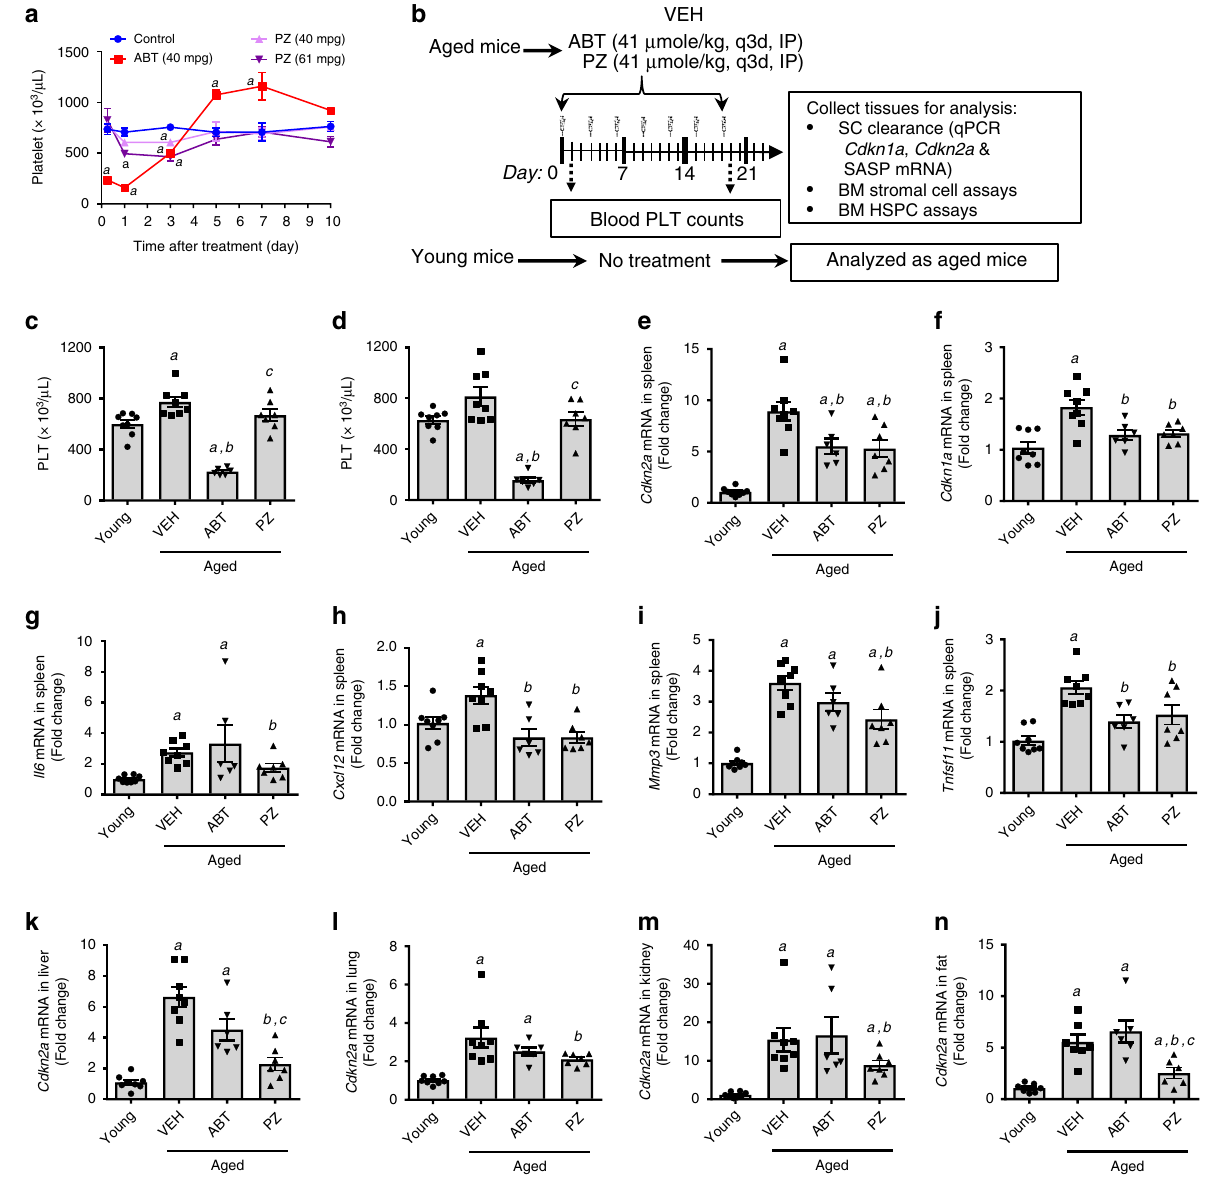
Fig. 3 PZ effectively clears SCs without causing thrombocytopenia in naturally aged mice. a Mice received an IP injection of vehicle (VEH), ABT263 (ABT) or PZ, and platelets (PLTs) were numerated at 6 h, day 1, 3, 5, 7, and 10 after the injection. Data are represented as mean ± SEM ( n = 3 mice/group). a p < 0.05 vs. control, determined by one-way ANOVA with Tukey ’ s post-hoc tests. b Illustration of the experiment design. Naturally aged mice (Aged) were given 41 μ mol/kg of PZ or ABT263 by IP injection every 3 days (q3d) for a total of 7 injections and euthanized 6 days after the last treatment to harvest various tissues and cells for analyses. Control untreated young mice (Young) mice were analyzed as aged mice without any treatment. Blood PLTs counts in Young and naturally aged mice were measured 1 day after receiving the 1st ( c ) and 7th ( d ) IP injection of VEH, ABT263 (ABT) or PZ. The data presented are mean ± SEM. a , b , c p < 0.05 vs. Young, Aged + VEH and Aged + ABT, respectively. Expression of Cdkn2a ( e ) , Cdkn1a ( f ), Il6 ( g ) , Cxcl12 ( h ), Mmp3 ( i ), and Tnfsf11 ( j ) mRNA in the spleen, and expression of Cdkn2a mRNA in the liver ( k ), lung ( l ), kidney ( m ), and fat ( n ) of Young and naturally aged mice treated with VEH, ABT or PZ measured by quantitative PCR (qPCR) as illustrated in ( b ). The data presented are mean ± SEM. a , b , c p < 0.05 vs. Young, Aged + VEH and Aged + ABT, respectively. Data in c – n were analyzed by one-way ANOVA with Tukey ’ s post-hoc tests, or Kruskal – Wallis one- way ANOVA with Dunn ’ s post-hoc test, with n = 8, 8, 6, and 7 mice per group for Young, VEH-, ABT263-, and PZ-treated naturally aged mice, respectively. n n = 7, 7, 6, and 7 mice per group for Young, VEH-, ABT263-, and PZ-treated naturally aged mice, respectively. Source data are provided as a Source Data fi le. The exact P values are provided in the Source Data fi